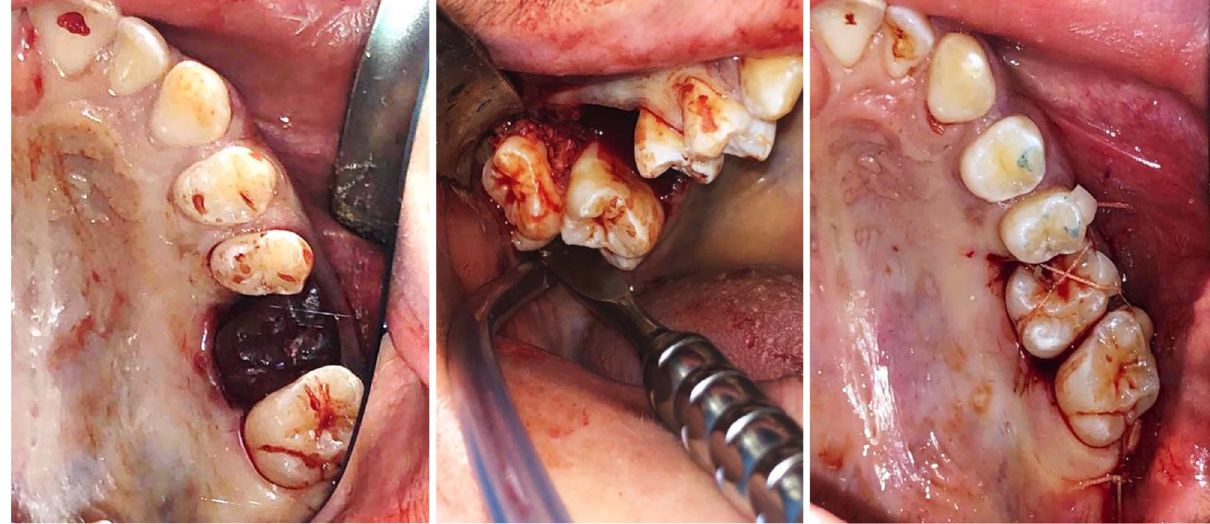
Fig. 4. Surgical view from left to right: 3D model placed in the socket after tooth extraction and socket conformation, atraumatic extraction of the germ of 18, 18 reimplantation stabilized by Vicryl-Hamac and 4/10 steel bar. Table I. Therapeutic possibilities [6,7], pros and